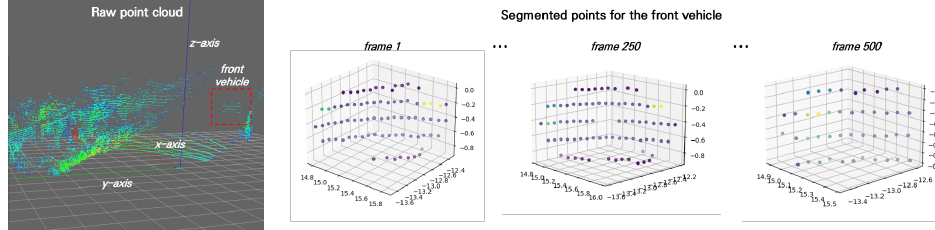
Figure 6. Example of scan data in the vibration test. ( left ) raw point cloud in a scan frame, ( right ) segmented points of the front vehicle using the feature extraction algorithm.